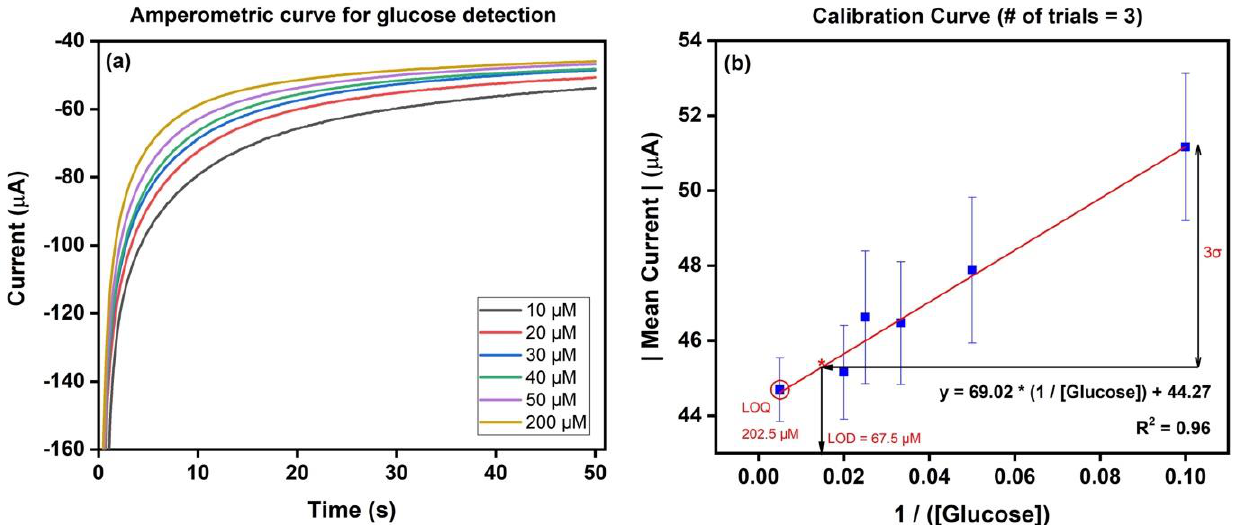
Figure 7. ( a ) Amperometric profile of the ZnO-modified micropipette tip used as a working electrode in 0.1 M NaCl at − 0.68 V in the presence of increasing concentrations of glucose (10 µ M–10 mM; only the linear range concentrations are represented in the figure). ( b ) Calibration curve for the developed sensor using a ZnO-modified micropipette tip as the working electrode to detect glucose, upon performing three trials (LOD and theoretical LOQ have been represented).